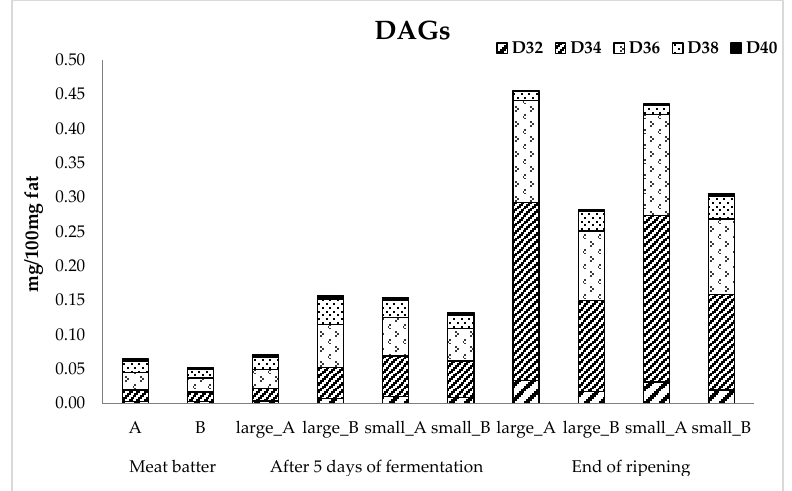
Figure 4. Principal DAG profile in the meat batter and in sausages inoculated with a different starter ( L. sakei / S. xylosus and P. pentosaceus / S. xylosus ) and with different diameters (large and small) during fermentation and